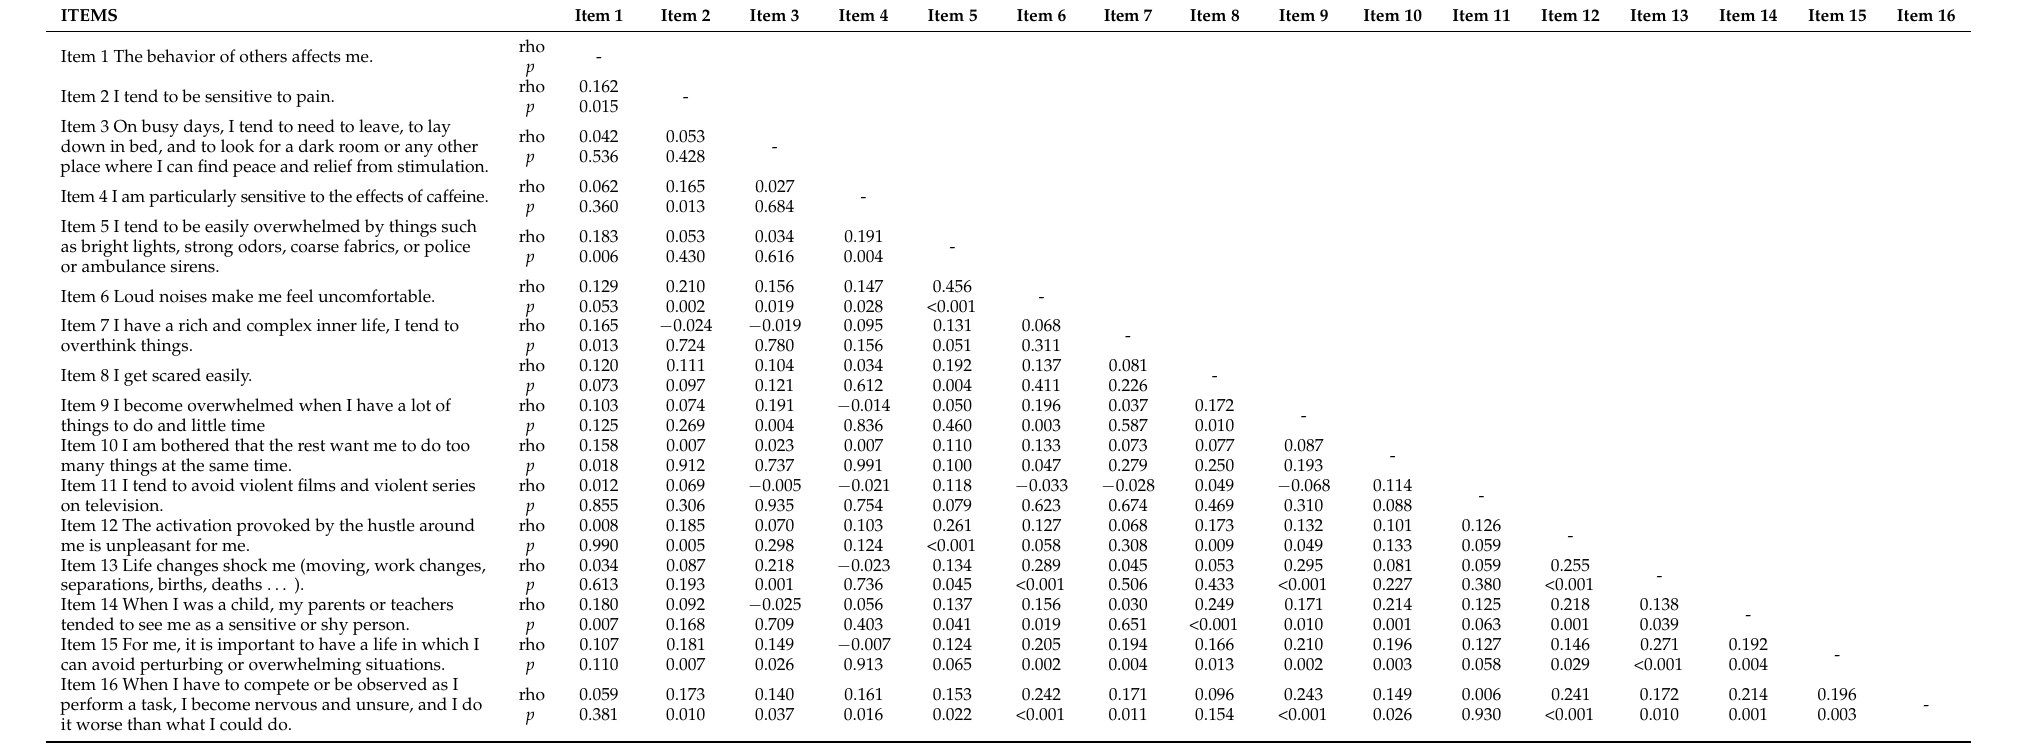
Table 2. Correlation among the different questionnaire